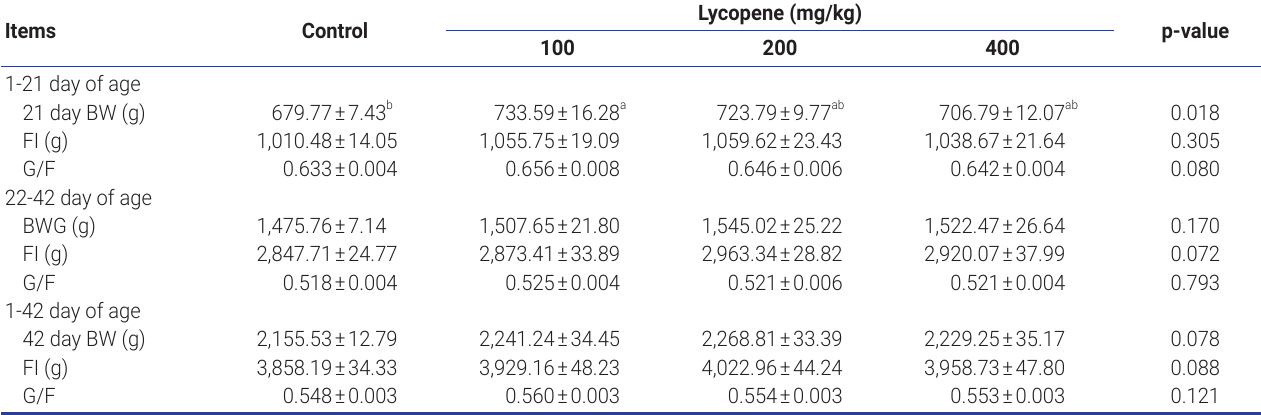
Table 3. Effects of lycopene on growth performance of broiler chickens Items